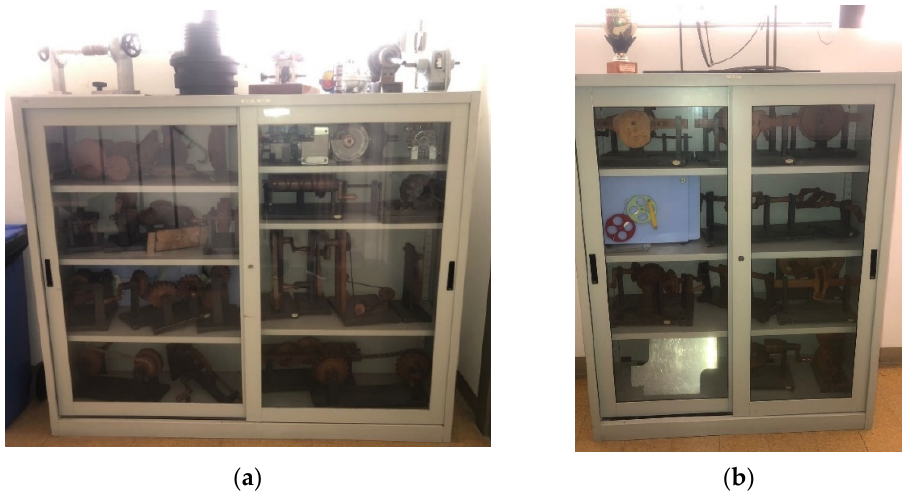
Figure 12. The collection of models of mechanisms at the Department of Industrial Engineering at the University of Bologna: ( a ) main wardrobe; ( b ) secondary wardrobe.